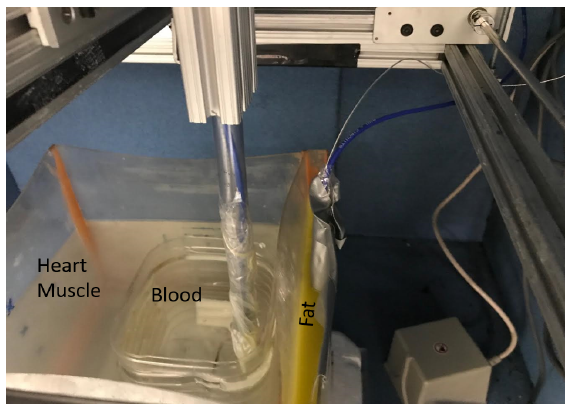
Figure 9. Multilayer phantom container inside anechoic chamber.